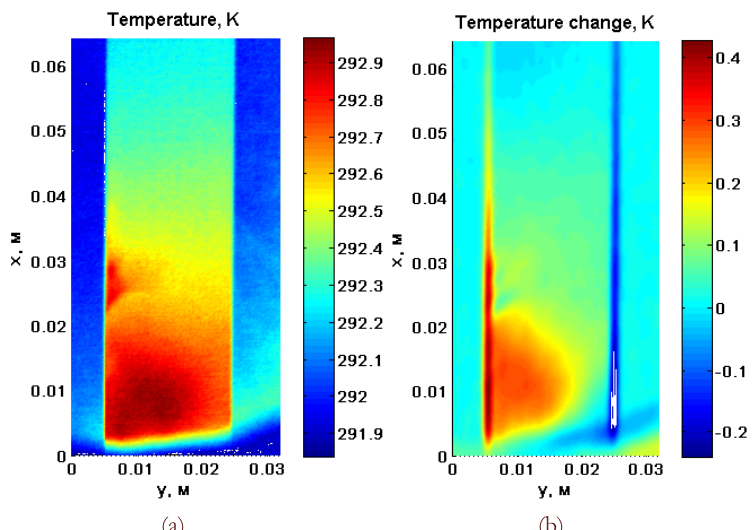
Figure 2: Infrared image of the smooth specimen before data processing (a) and the obtained temperature change field